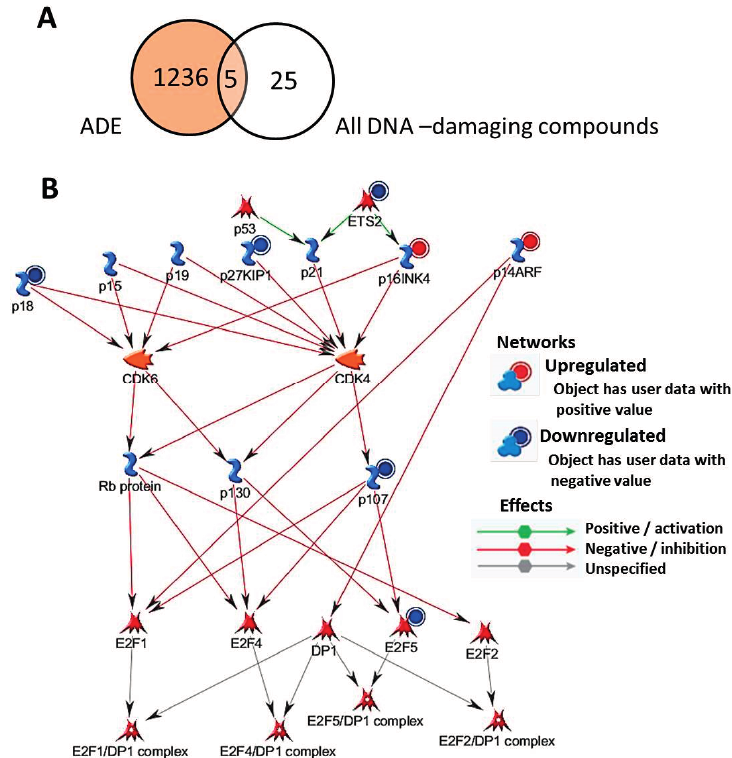
Figure 3. Pathway enrichment analysis for toxicity networks showing E2F downregulation. Venn diagram ( A ) showing intersection of gene sets. Five of 1241 probes were altered in common on treatments with adenine (ADE) and DNA damage-inducing clastogens, while 1236 probes were specifically altered on ADE treatment. The network comprising the regulation of cyclin-dependent kinase (CDK) 4, 6 by CDK inhibitors ( B ) was obtained by pathway enrichment analysis showing E2F downregulation using the 1236 ADE-induced genes depicted in ( A ) by